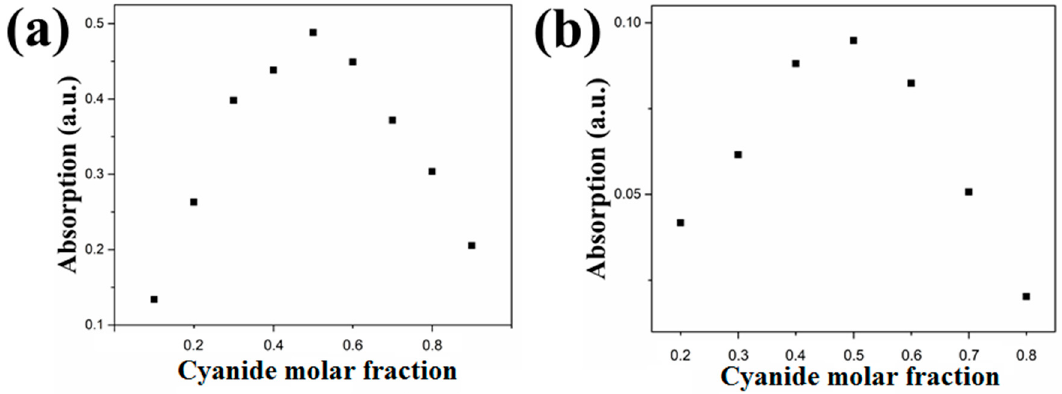
Figure 6. Job plots of 1 ( a ) and 2 ( b ). The monitored wavelengths are 425 nm and 435 nm,